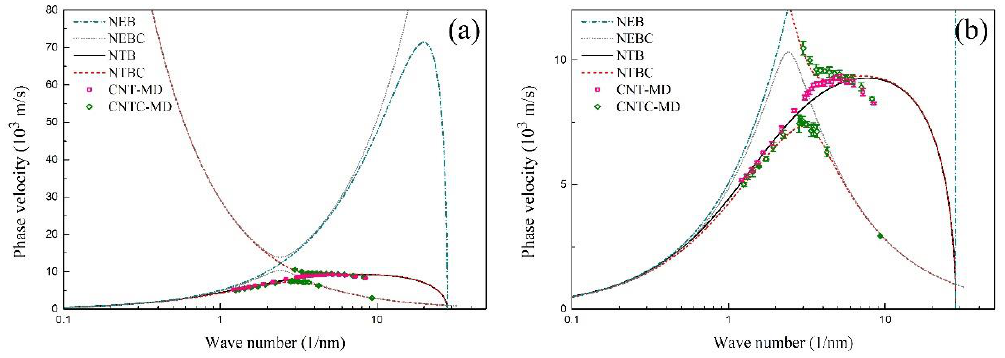
Figure 5. ( a ) The phase velocity versus the wave number of the SWCNT and the CCSC; ( b ) the zoom